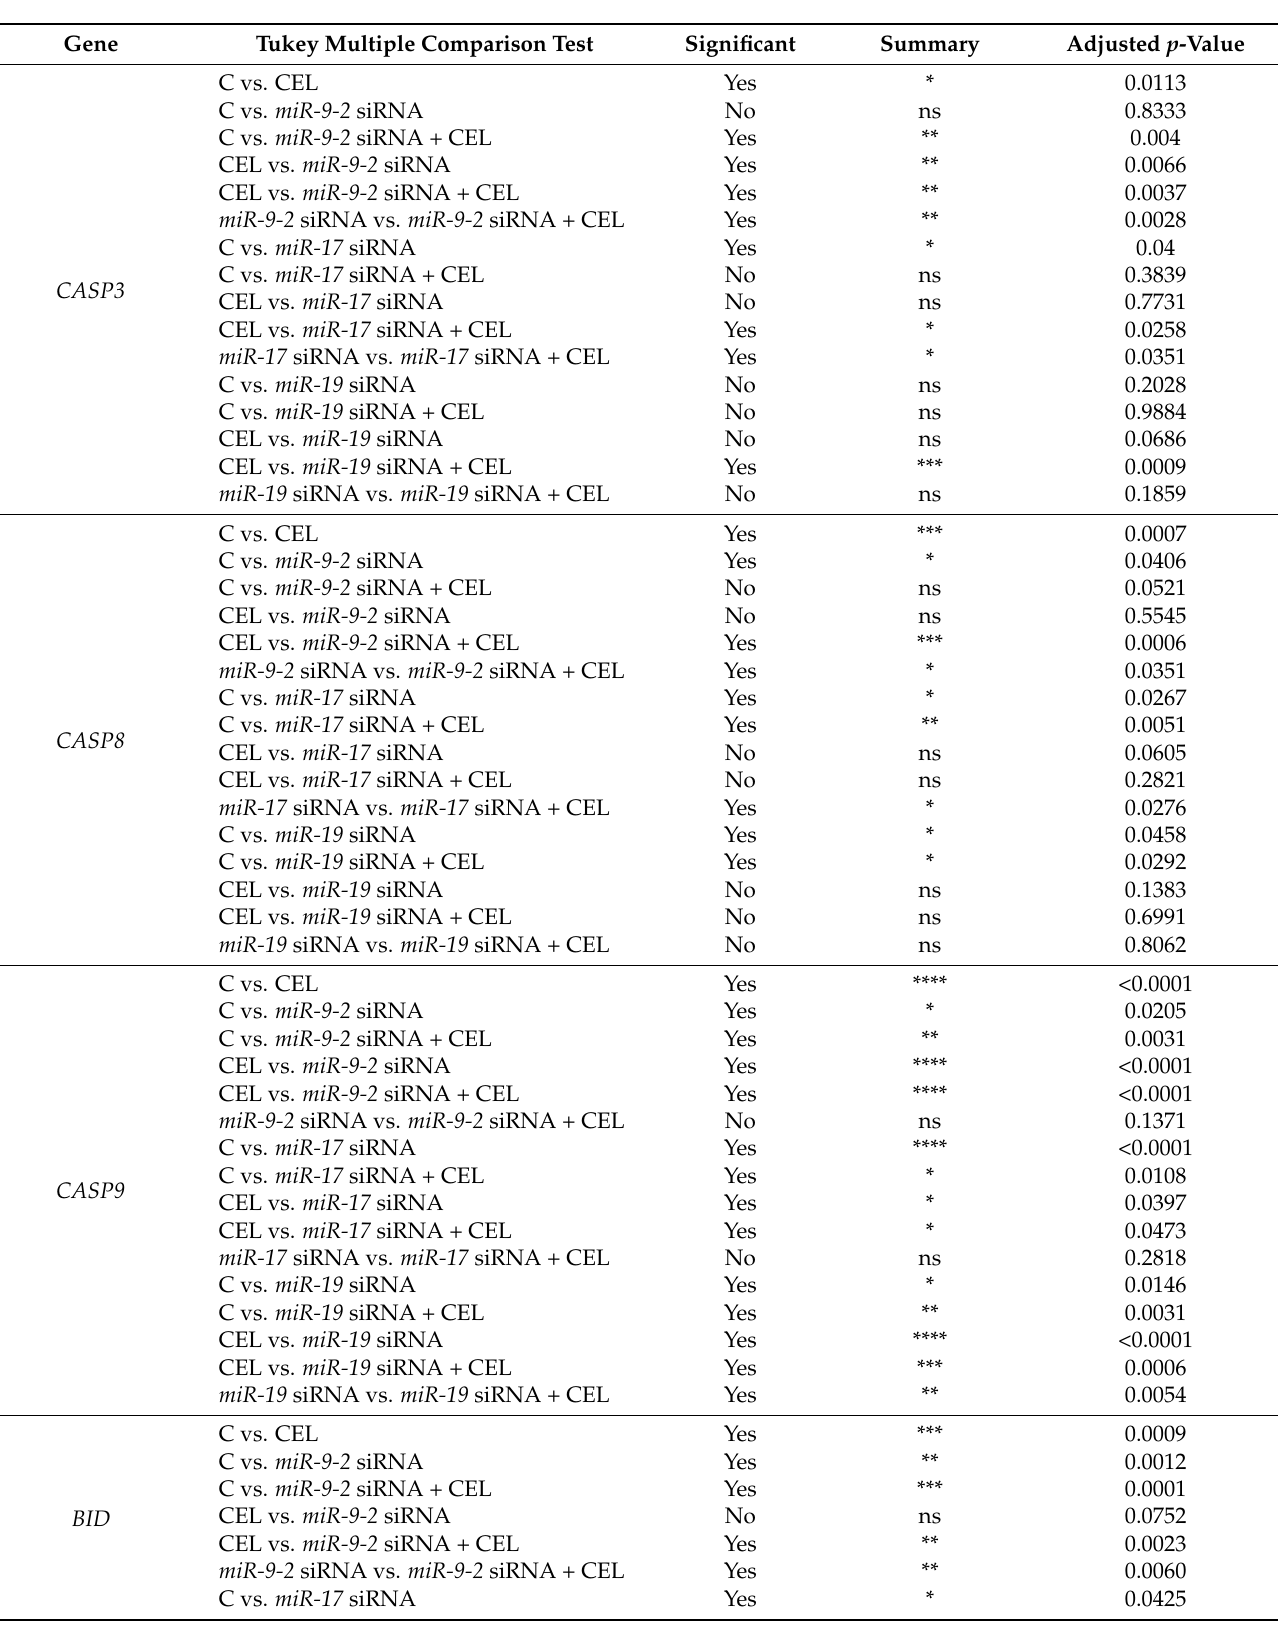
Table 4. Results of the one-way ANOVA followed by the post-hoc Tukey test in Figure 3.